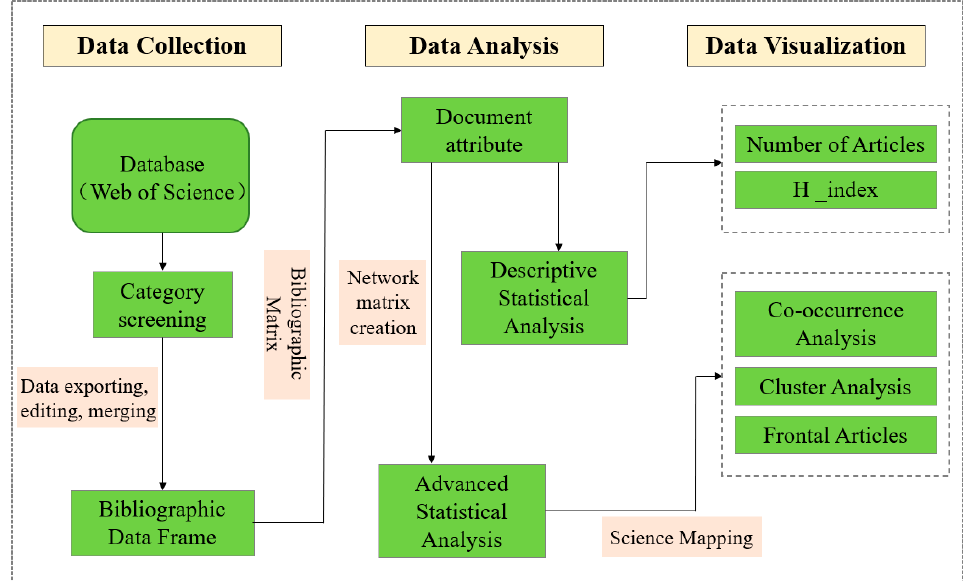
Figure 1. Science mapping workflow of Bibliometrix.